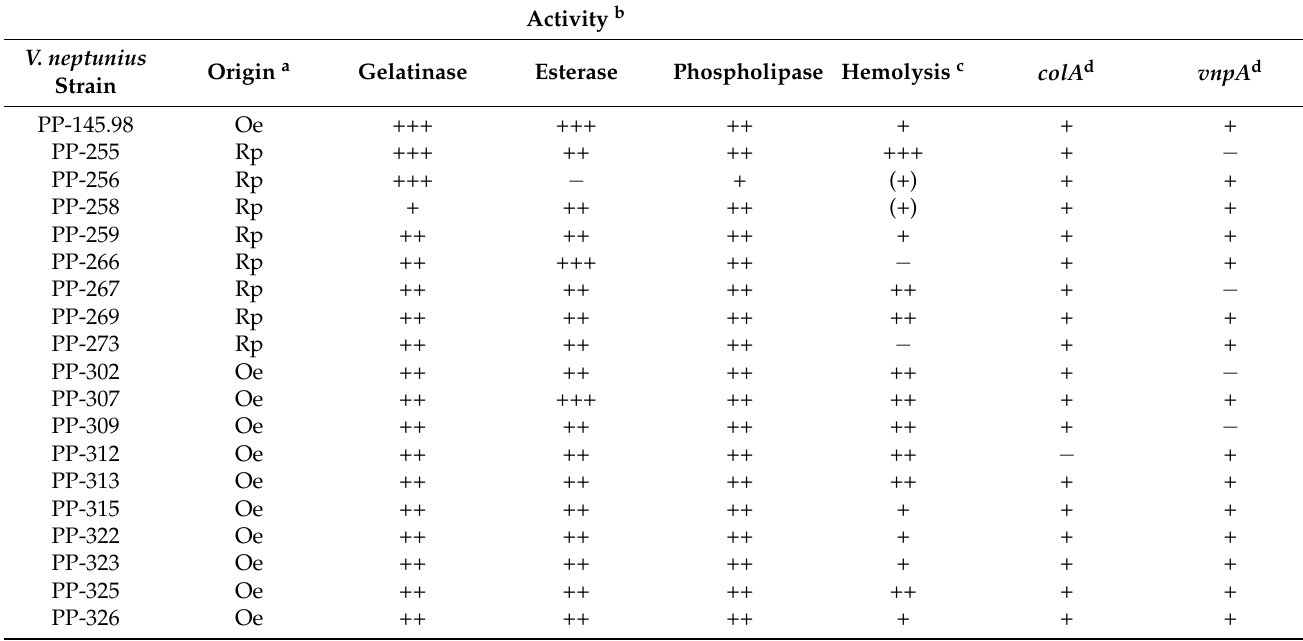
Table 3. Extracellular hydrolytic activities and the presence of colA and vnpA genes in a collection of V. neptunius strains. Activity